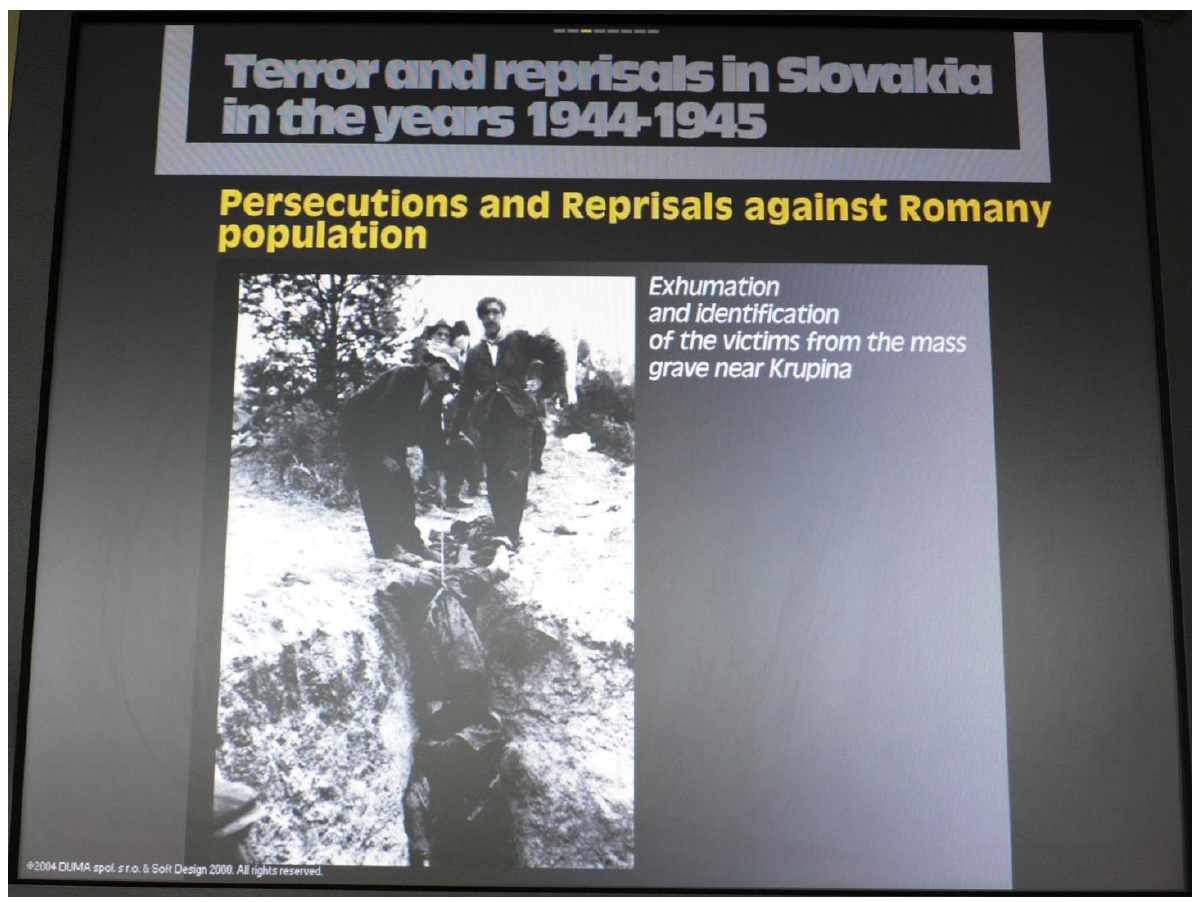
Figure 2. Photograph shown on an info-screen at the Museum of Slovak National Uprising